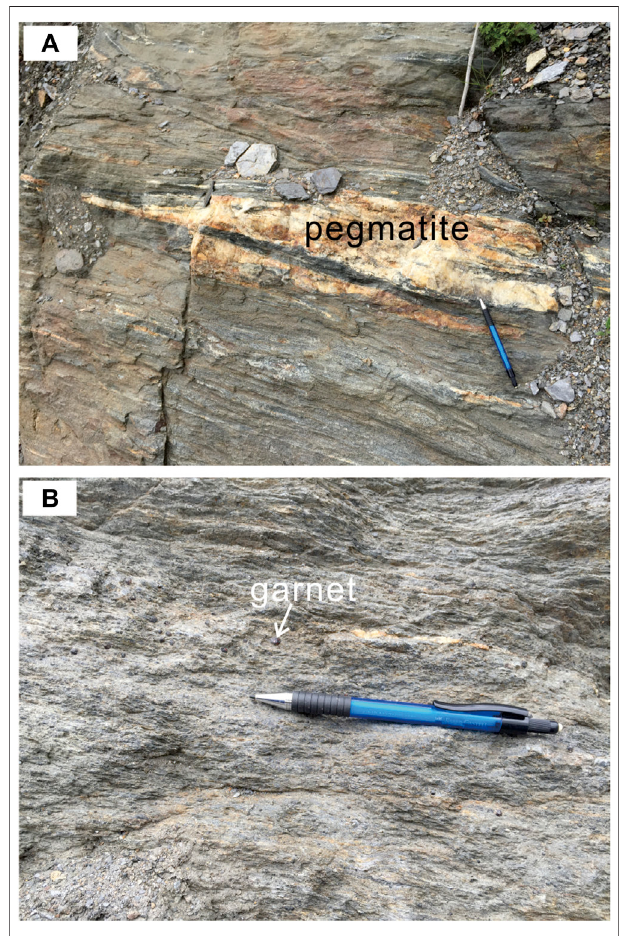
FIGURE 3 | Field photographs of garnet – staurolite – two-mica schist in the Ramba gneiss dome.